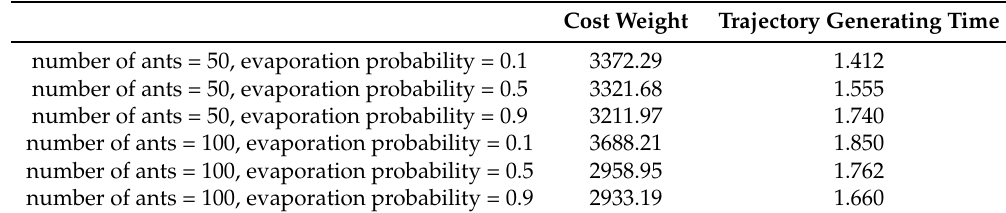
Table 9. Comparison results of parameters setting for ACO.